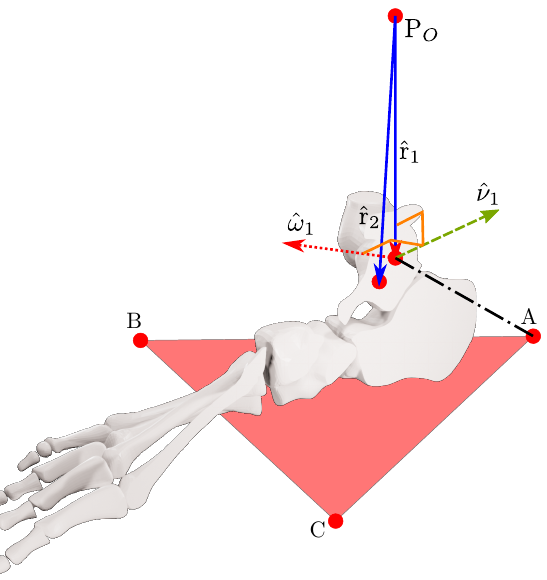
Figure 5. Vectors and points on the sagittal